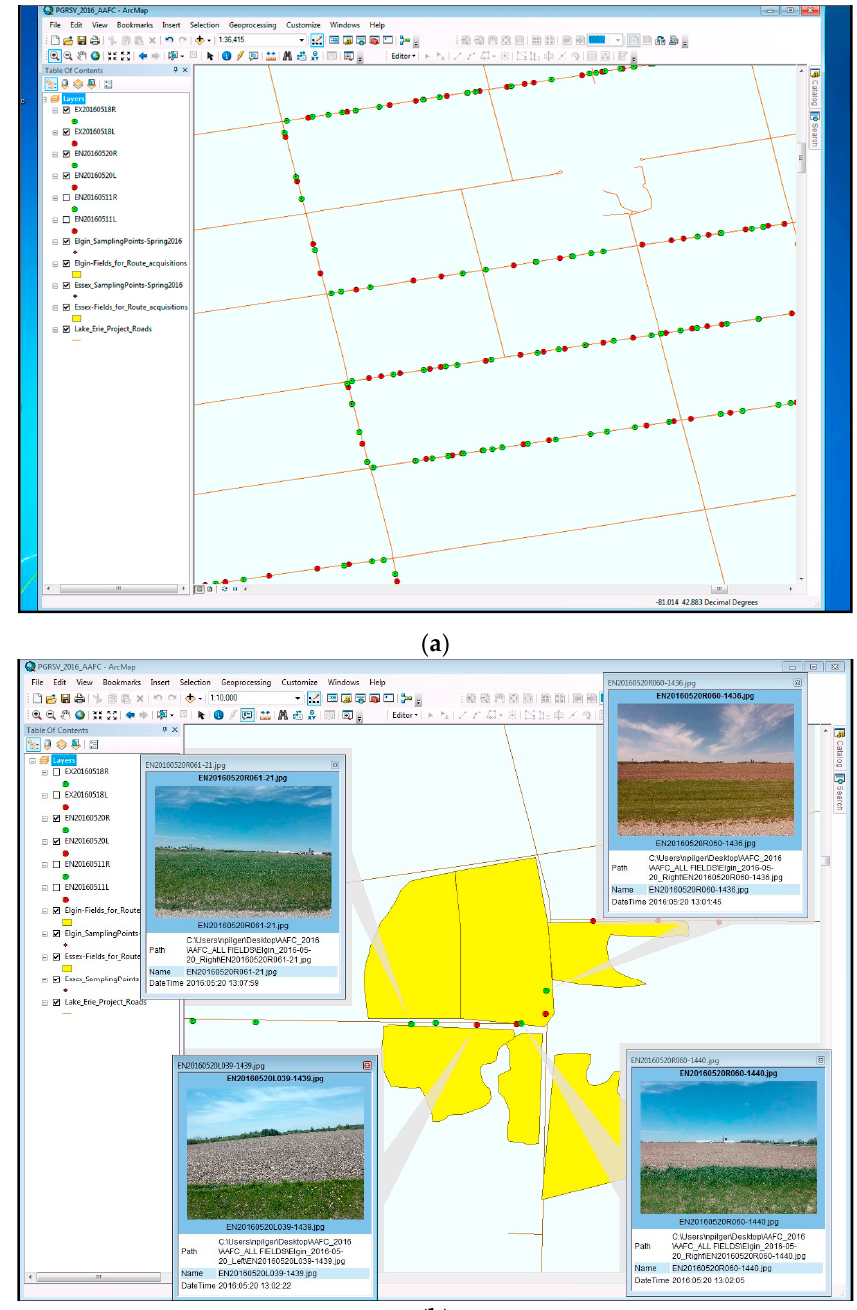
Figure 3. Examples of the georeferenced roadside survey. ( a ) illustrates roadside survey locations, with green points showing photos taken from right side of the vehicle (driving direction), and red from the left. Vehicle driving directions can be determined from the embedded time stamps in the photos. ( b ) illustrates examples of the photos acquired for the polygons of the sampled agricultural fields.